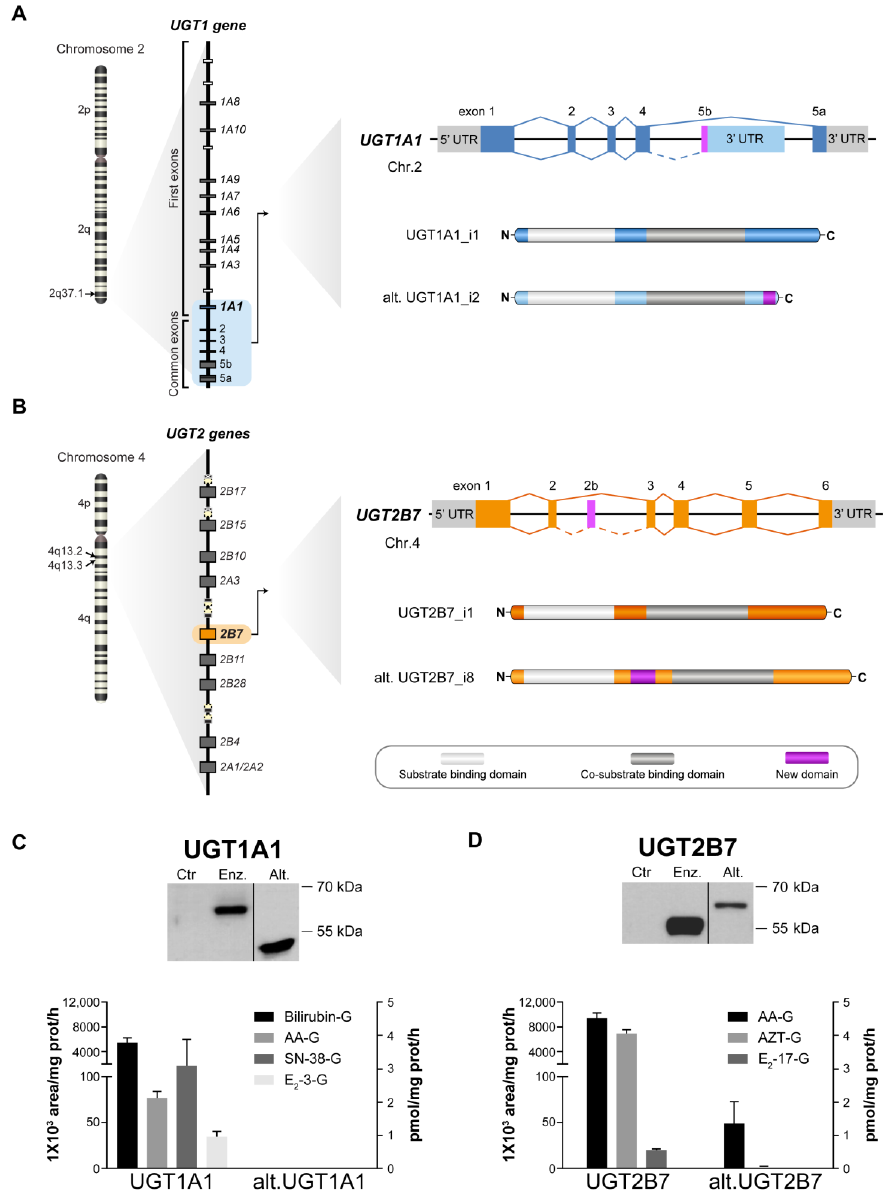
Figure 1. Expression and activity of UGT enzymes and alt. proteins in UGT-negative HEK293 cells. ( A ) UGT1A1 and ( B ) UGT2B7 as prototypical examples of the family UGT1A and UGT2, respectively. The splicing events in the UGT1 and UGT2B genes leading to the UGT1A1 and UGT2B7 canonical enzymes (full lines) and alt. proteins (dashed lines) are schematized. The UGT1A1_i2 alternative protein (alt. UGT1A1) possess a truncated C-terminal, resulting from a stop codon located in the exon 5b, whereas the UGT2B7_i8 alternative protein (alt. UGT2B7) has an in-frame insertion of 32 amino acids encoded by the exon 2b. Stable expression and glucuronidation activity of UGT1A1 ( C ) and UGT2B7 ( D ) enzymes (enz.) or alternative proteins (alt.) in HEK293 cells. Expression was revealed by immunoblotting of microsomal fractions of UGT-expressing cell models and control cells (Ctr). UGT1A1 and UGT2B7 enzymes displayed enzymatic activity toward typical substrates of these isoenzymes. Assays were conducted with microsomal extracts of each cell model incubated with bilirubin, arachidonic acid (AA), estradiol (E2), 7-ethyl-10-hydroxy-camptothecin (SN-38) or zidovudine (AZT). Activities are reported in pmol/mg prot/h (right axis), except for bilirubin and AA (1 × 10 3 area/mg prot/h; left axis). No activity was detected in Ctr cells (not